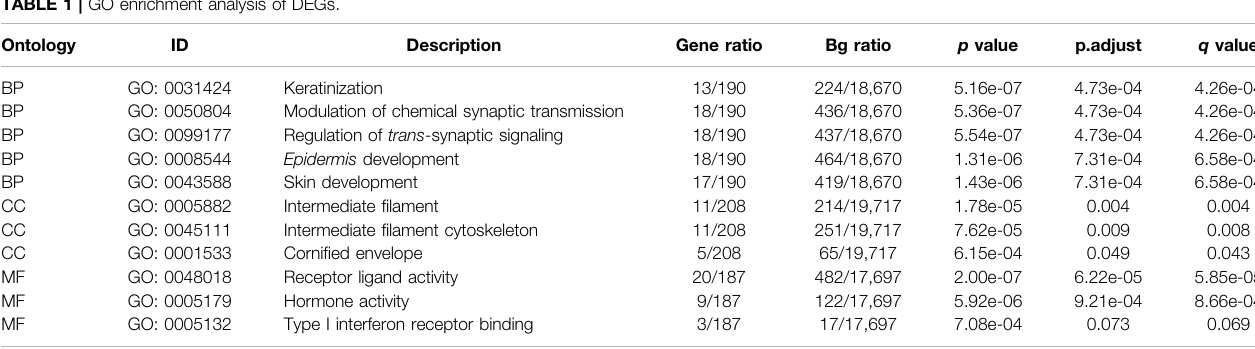
TABLE 1 | GO enrichment analysis of